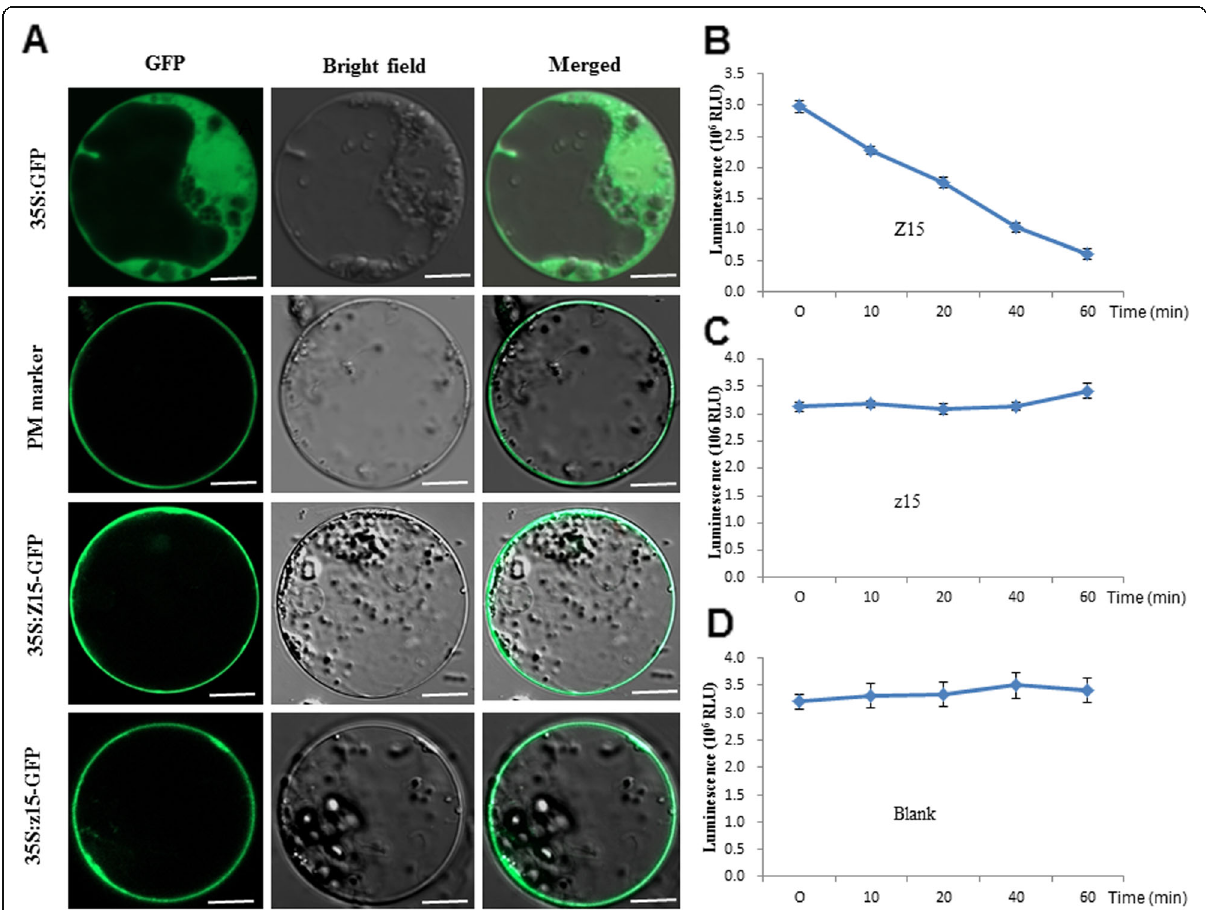
Fig. 3 Subcellular localization and kinase activities of Z15 and z15 proteins. a Analysis of Z15 and z15 subcellular localizationin rice protoplasts. ESL4-GFP was used as a plasma membrane (PM) marker. Scale bars are 10 μ m; b - d , kinase activity in presence of recombinant Z15 ( b ) or z15 ( c ) and in absence of recombinant protein ( d ). The data are shown as the mean ± SD ( n =